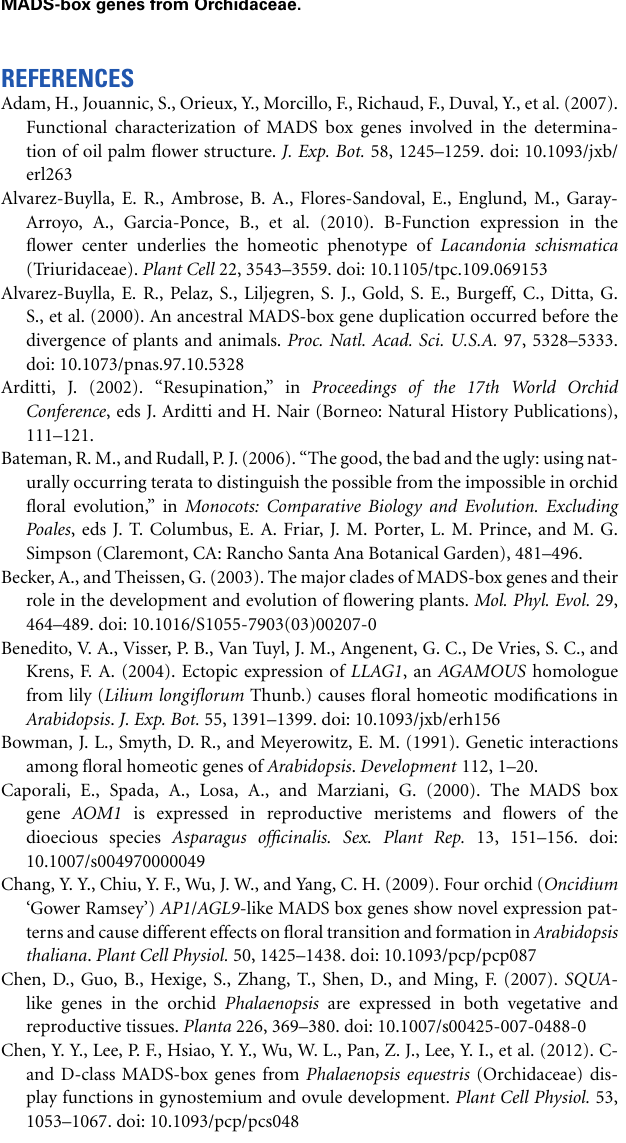
Supplementary Table I | Characteristics and sequences of the primers pairs employed for qPCR. Supplementary Table II | List of sequences employed in alignments, phylogenetic analysis and primer design. Supplementary Table III | Expression of FUL -, AG / STK and SEP -like MADS-box genes from